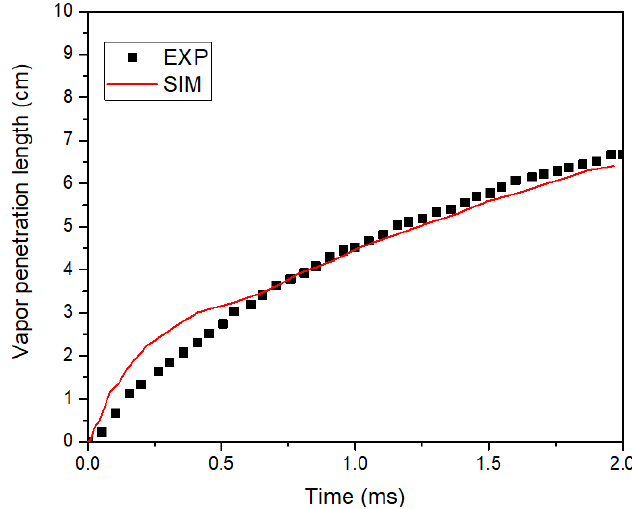
Figure 5. Comparison of experimental and numerical vapor penetration length (injection pulse = 2 ms, injection pressure = 40 MPa, ambient pressure = 3.5 MPa, and ambient temperature = 600 K). The combustion model was calibrated with the experimental pressure trace at an altitude of 4.5 km. As shown in Figure 6, a noticeable difference between the numer- ical ensemble-averaged pressure and sensor-measured pressure was observed at the 4.5 km altitude, which was caused by the pressure inhomogeneity resulting from strong pressure oscillation. However, the local pressure predicted by CFD in the cell of the location near the pressure sensor was in good agreement with measurements. Ad- ditionally, consistency was observed at altitudes of 3 and 1 km, and the differences between experimental and numerical results were generally within a 2% error bar, as shown in Figures 7 and 8.